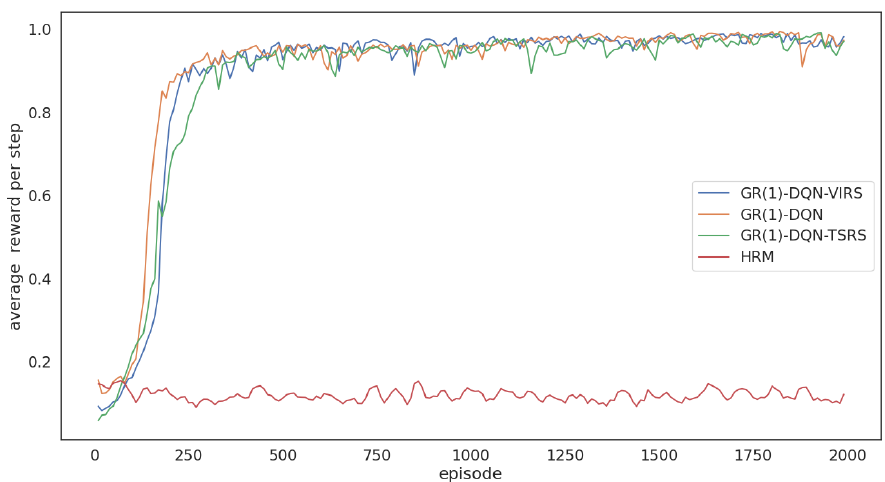
Figure 5. Comparison of learning curves for multi-task reinforcement learning algorithms with ϕ 1 under the same stochastic environment.